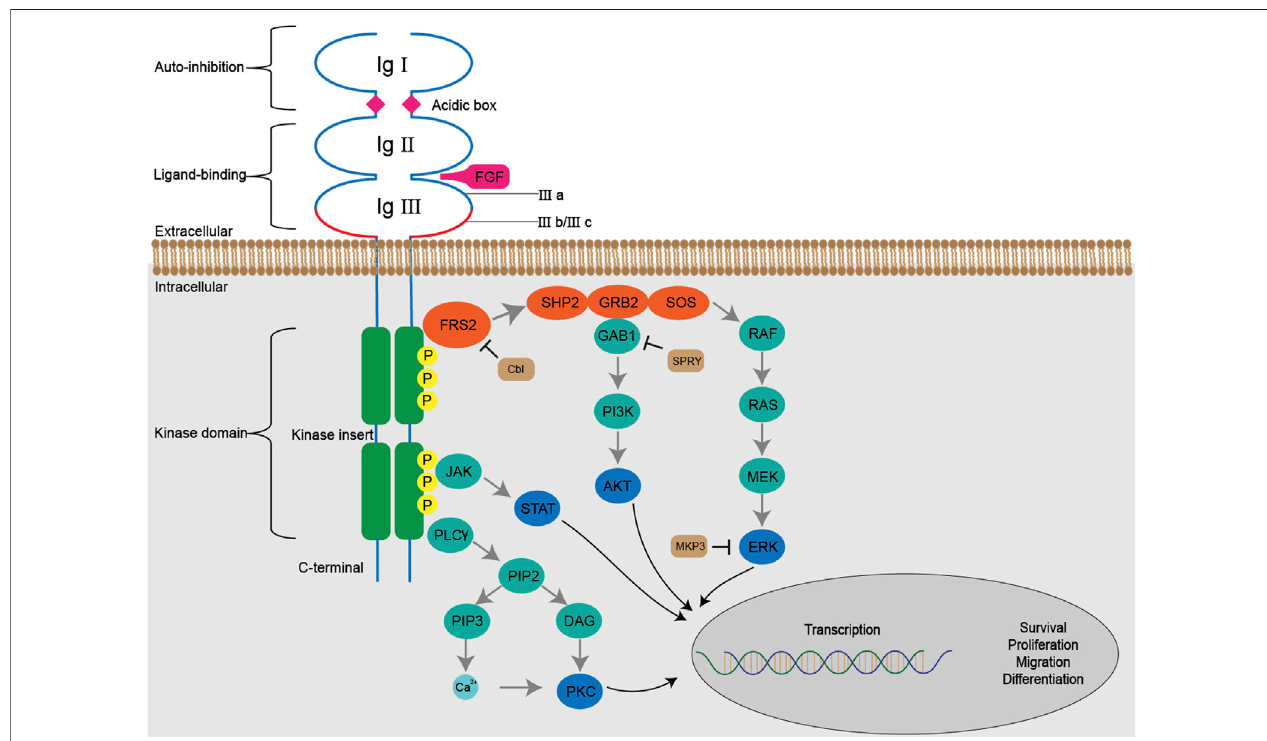
FIGURE 3 | The FGF/FGFR signaling pathways. The binding of FGFs with FGFRs initiates a series of conformational changes, which consequently result in phosphorylation of tyrosine residues in the kinase domain. The phosphorylated tyrosine triggers cascaded docking and phosphorylation of downstream molecules including SHP2, GRB2, GAB1 and SOS, forms a multi-complex, and subsequently activates RAS-MAPK-ERK and PI3K-AKT pathways. Activated FGFRs are also involved in JAK-STAT and PLC γ -PKC pathways. The Cbl, SPRY, MKP3 negatively regulate FGF/FGFR signaling by ubiquitination, docking prevention and dephosphorylation,